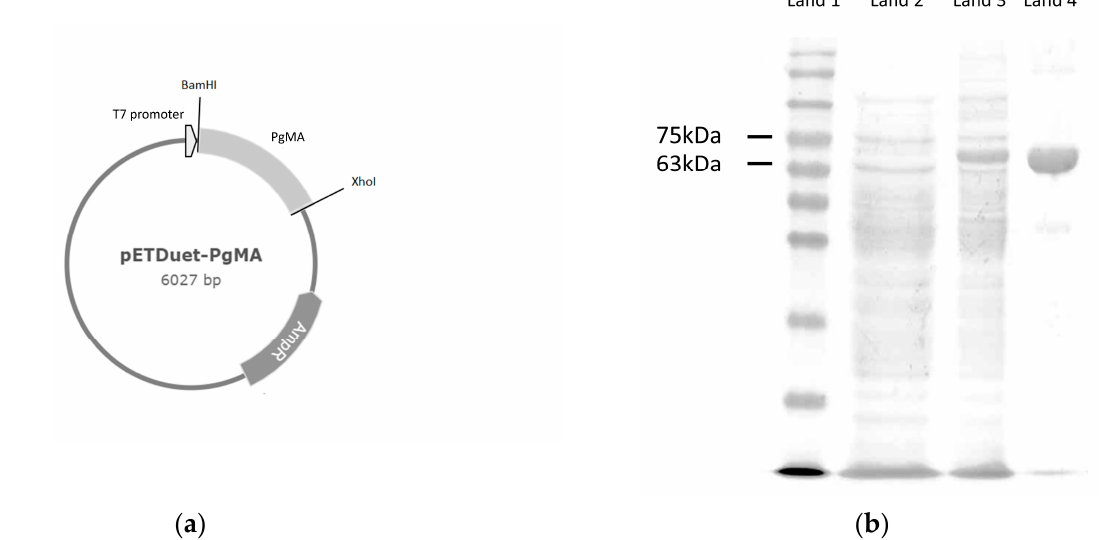
Figure 2. Expression of Pg MA from Parageobacillus galactosidasius DSM 18751T in Escherichia coli (DE3). ( a ) Recombinant repression plasmid pETDuet- Pg MA. ( b ) Sodium dodecyl sulfate-polyacrylamide gel electrophoresis (SDS-PAGE) analysis of expressed and purified proteins from recombinant E. coli harboring pETDuet- Pg MA. Lane 1: molecular marker; lane 2: total protein before induction; lane 3: total protein after 20 h of induction; and lane 4: purified protein.